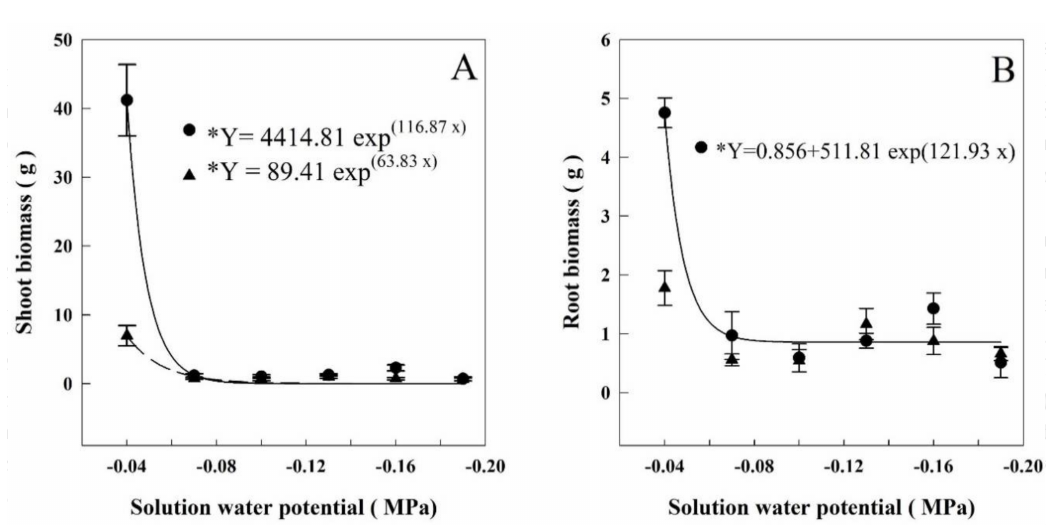
Figure 2. Shoot ( A ) and root ( B ) biomasses of rice plants grown at different solutions with different water potentials. The error bars represent the standard error. * p -value < 0.01; • = HET; (cid:78) =